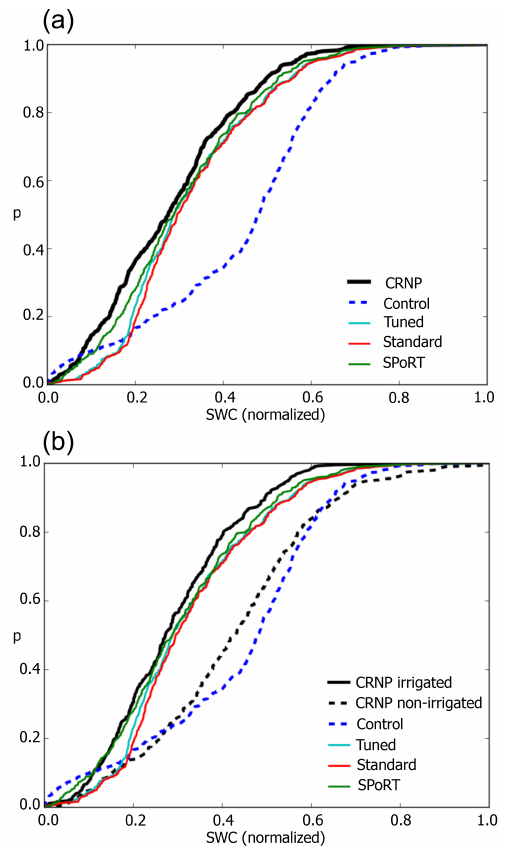
Figure 9. CDF of normalized (a) domain averaged and (b) irrigated/non-irrigated spatial average soil water content (SWC) values from 5 May to 16 September from the COSMOS observa- tional product (black) and the model simulations